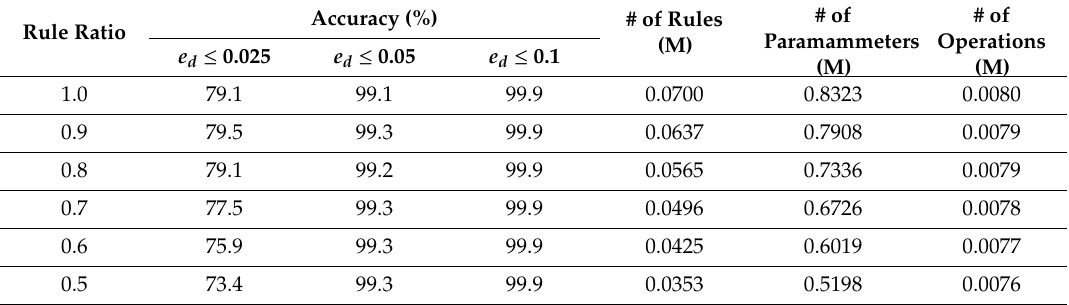
Table 2. Performance evaluation results in terms of accuracy and numbers of rules, parameters, and operations of the proposed method according to changes in the rule distillation when using the GI4E